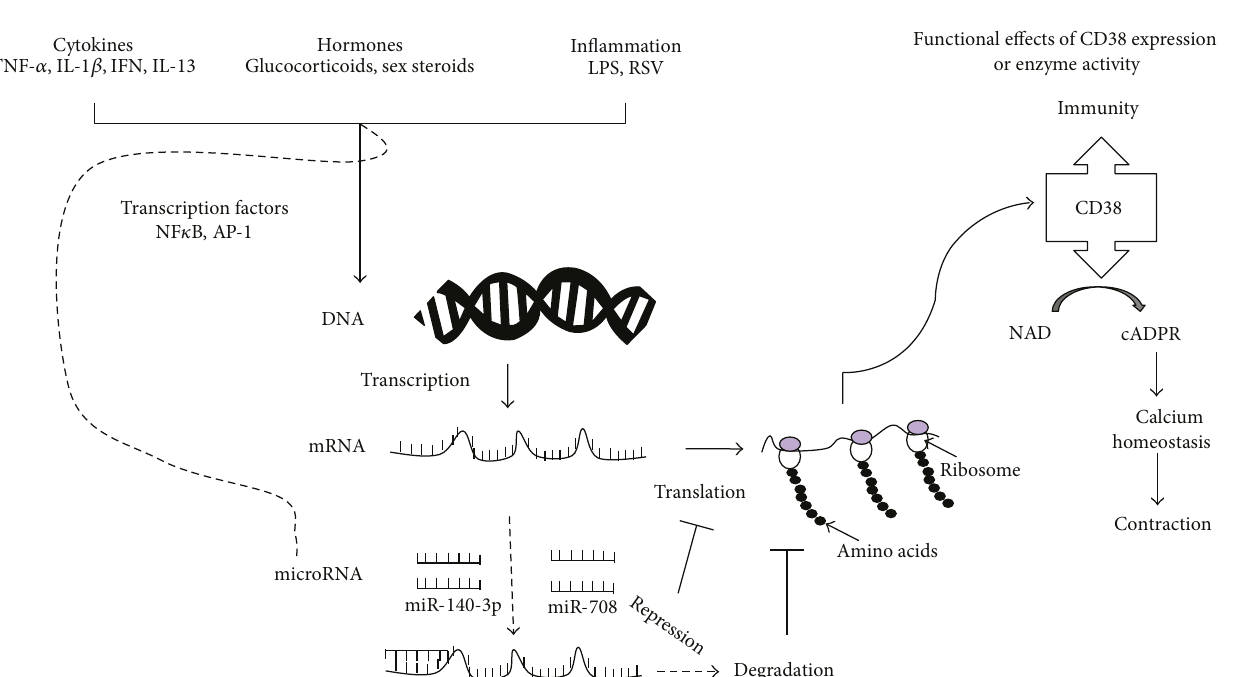
Figure 1: Regulation of expression and functional role of CD38. Bifunctional enzyme CD38 is expressed on a variety of immune and mesenchymal cells including on airway smooth muscle cells. In immune cells, CD38 serves as a cell surface marker and contributes to in fl ammatory response. CD38 via production of cADPR, a calcium elevating second messenger, contributes to smooth muscle contractility and airway hyperresponsiveness (right half). Regulating CD38 expression, its enzyme activity or cADPR levels in e ff ector cells may lead to human pathologies. In fl ammatory cytokines, hormones, and other in fl ammatory mediators regulate CD38 expression via activation of transcription factors such as NF- κ B and AP-1 or via expression of speci fi c microRNAs (left half). Overall, CD38 expression can be modulated at transcriptional level as well as posttranscriptionally by